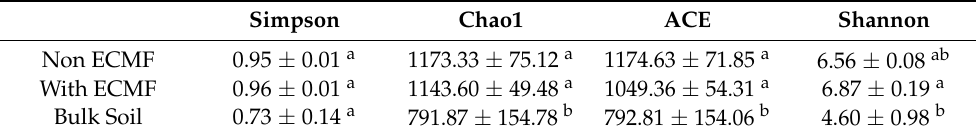
Table 2. Statistic of fungal diversity and richness from nine soil